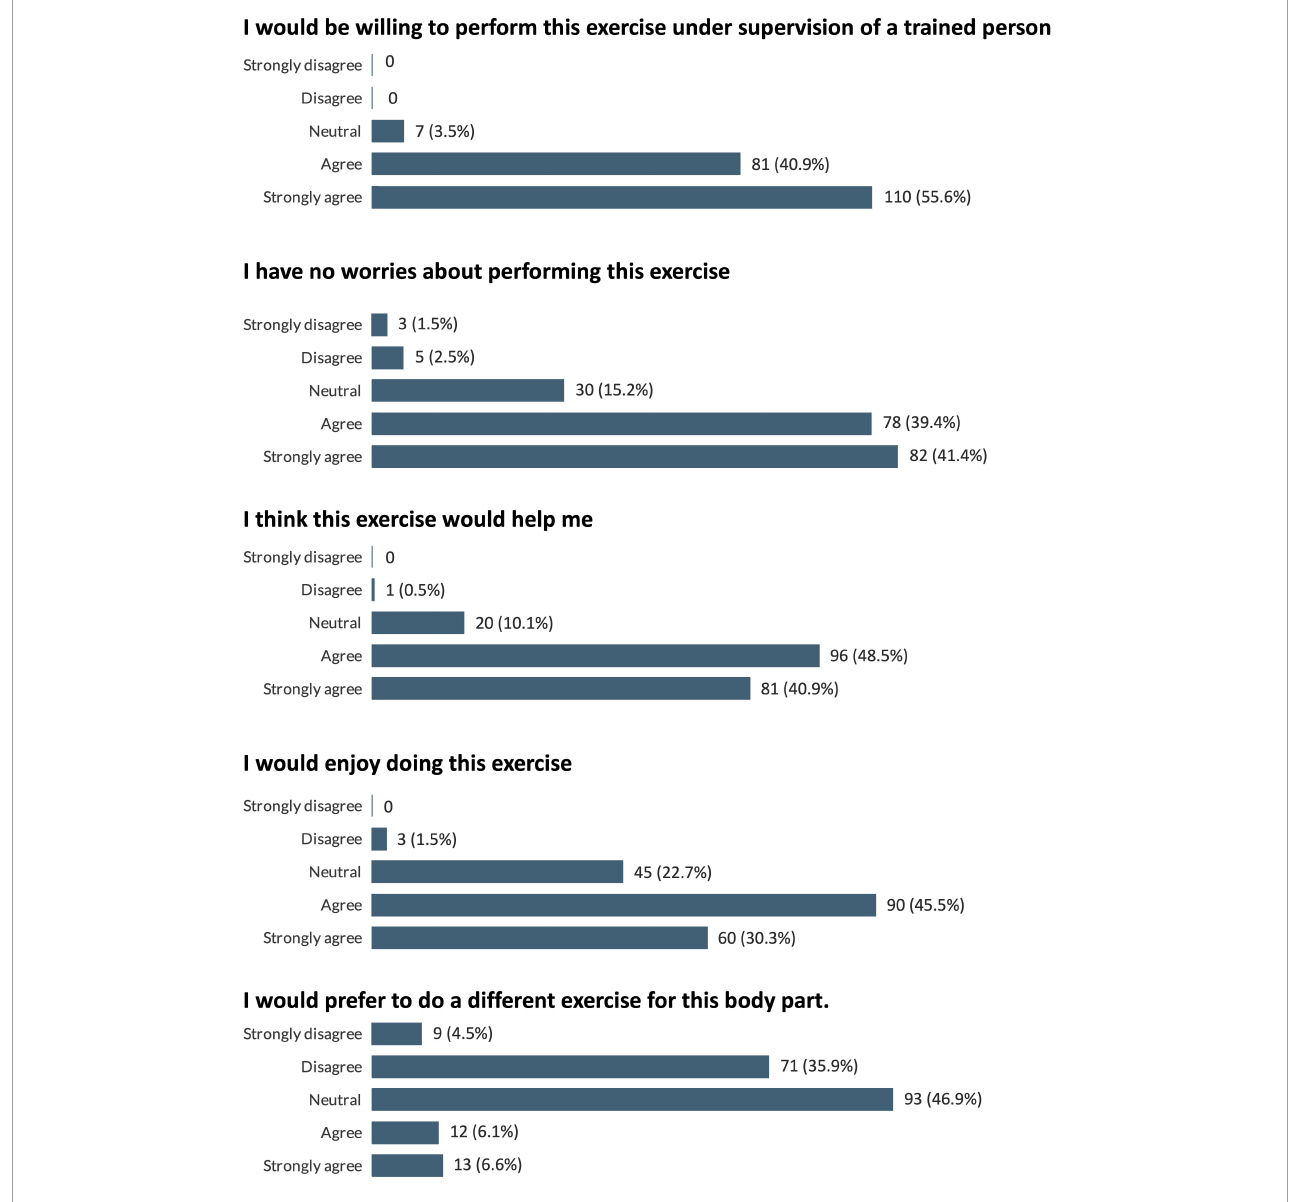
FIGURE7 Pooled participant responses to questions relating to impressions of the proposed resistance exercises. Displayed as number and (percentage) of responses to each answer option (e.g., 100% would represent that all this question’s responses chose that